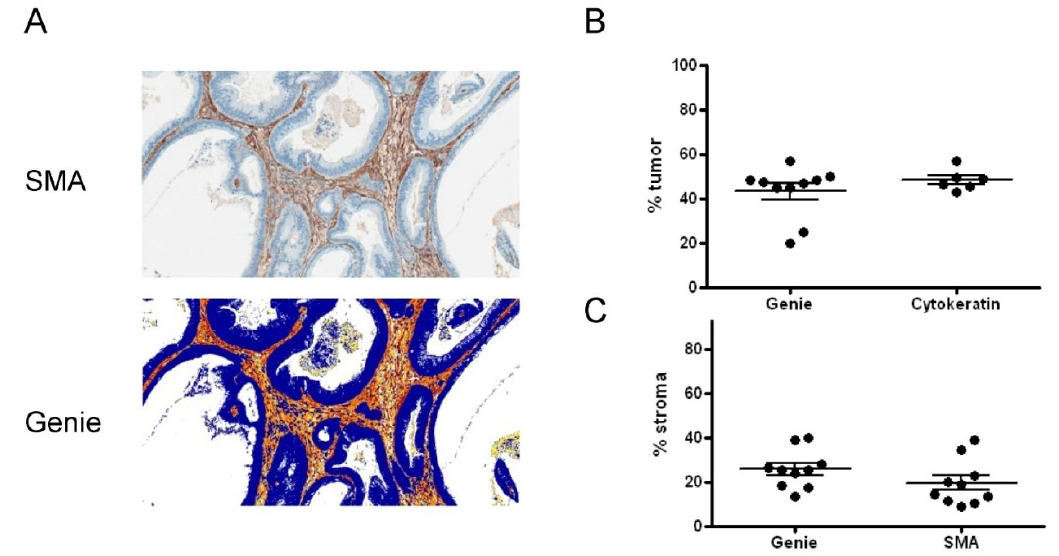
Figure A2. The Genie pattern recognition software can be used to evaluate tumor and stoma content. ( A ) Representative images of α-SMA (top) and EF5 stained sections classified with the stroma classifier (bottom). Classification of the ( B ) epithelial and the ( C ) stromal compartment using the Genie classifiers closely resembles the histological staining for cytokeratin and α-SMA,